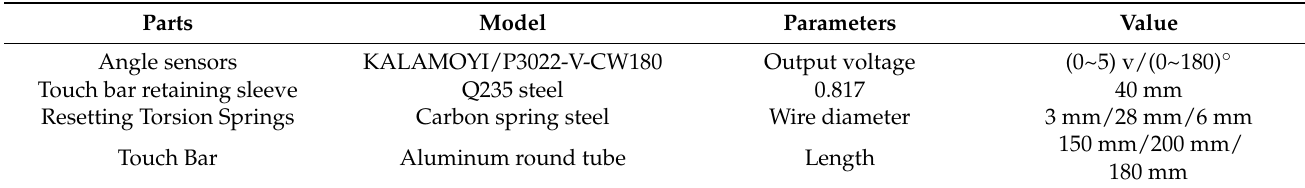
Table 1. The main parameters of the touch-to-travel mechanism.